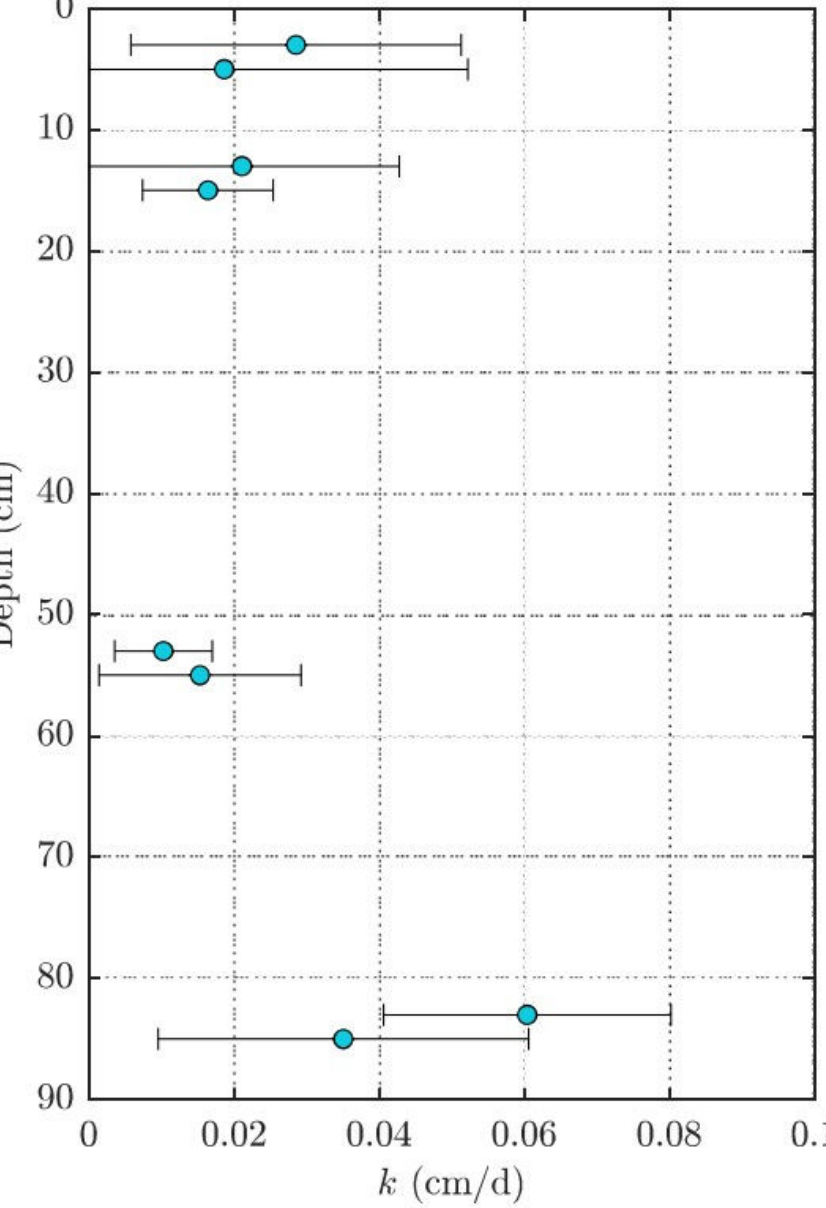
Figure 4. Local mass-transfer coefficient ( k , cm/d) at depth of d-PAH performance reference com- pounds at sample location 20 (S20) within the NE sampling locations. The standard deviation in mass transfer reflects the uncertainty in PRC quantified from the PDMS passive